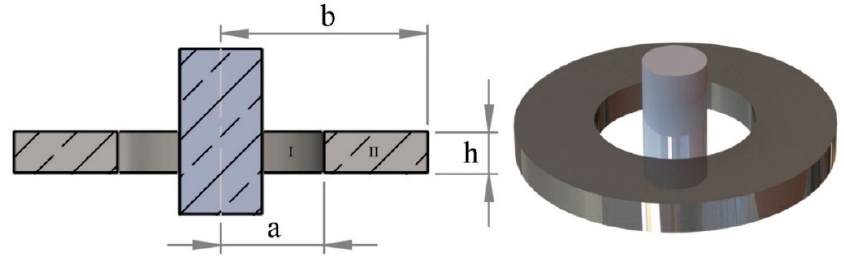
Figure 2. Tank wall geometry for calculating the electromagnetic field (EMF).